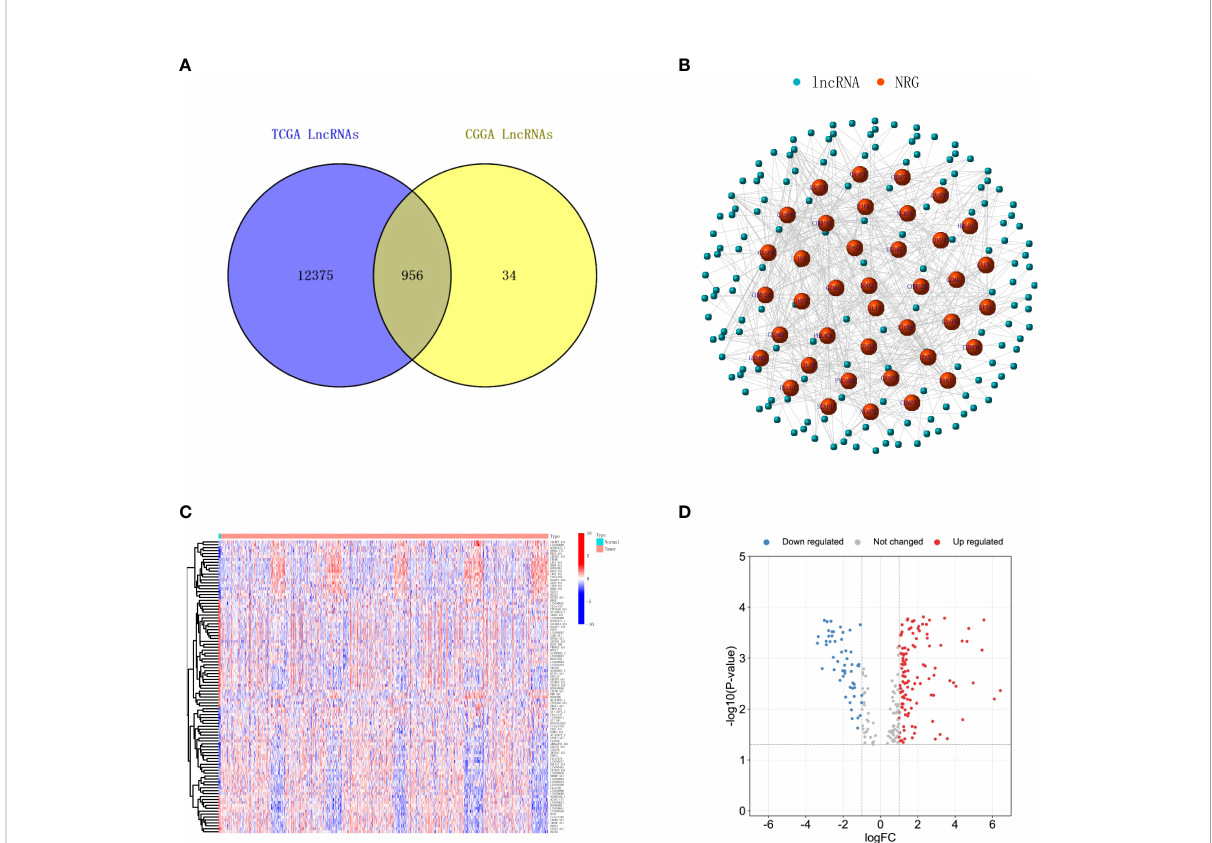
FIGURE 1 Identi fi cation of necroptosis-related lncRNAs in glioma. (A) Venn diagram shows the lncRNAs common to TCGA and CGGA datasets. (B) A co ‐ expression network of the necroptosis-related lncRNAs was constructed and visualized to indicate the interactions among the necroptosis- related mRNAs and lncRNAs. (C) Heatmap illustrates the upregulation and downregulation top 50 necroptosis-related lncRNAs with the most signi fi cant differences. (D) Volcano plot depicts the necroptosis-related lncRNAs. The red dots indicate upregulated lncRNAs, while blue dots indicate downregulated lncRNAs. lncRNAs, long non-coding RNAs; TCGA, The Cancer Genome Atlas; CGGA, Chinese Glioma Genome